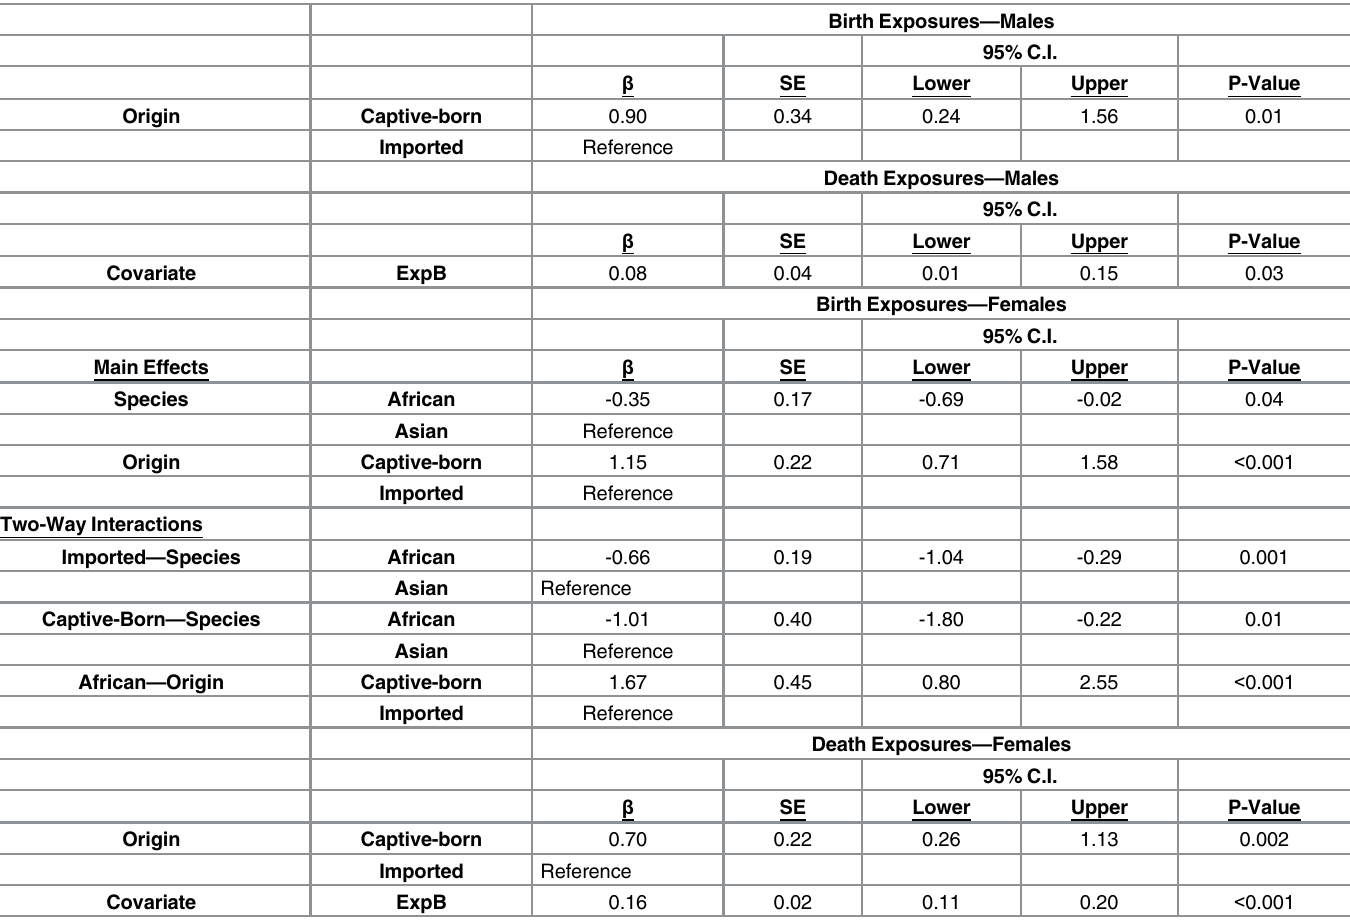
Table 9. Summary of parameter estimates from negative binomial regression models, including beta estimates, standard errors (SE) and corre- sponding 95% confidence intervals. p <